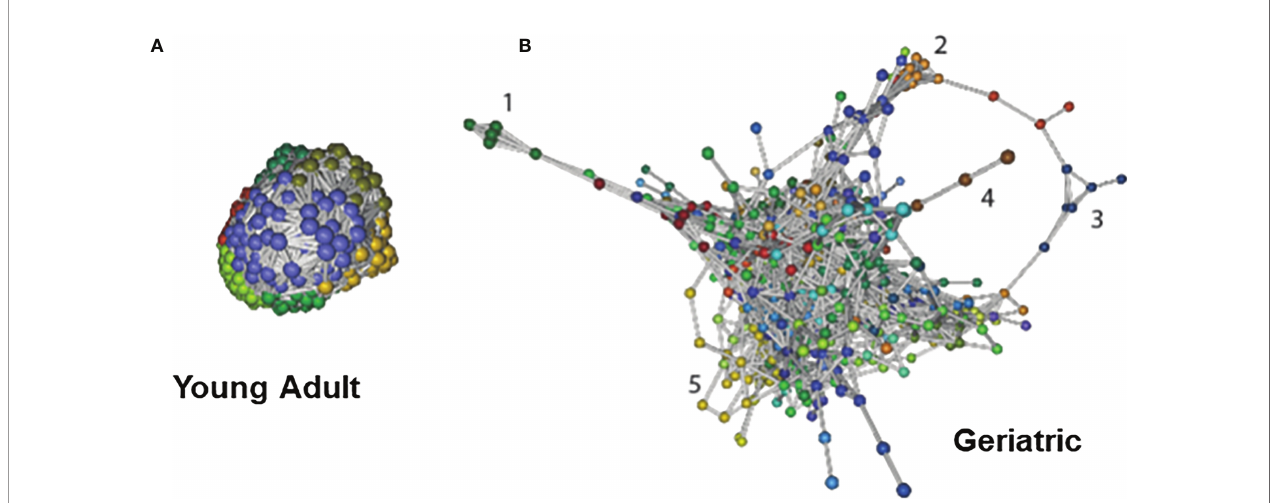
FIGURE 6 | Bacterial association networks and differences with age: Bacterial association networks and differences with age: Markov Clustering Algorithm (MCL) evaluates correlations of vector abundance of bacterial species within each group, thereby generating a cluster map by using correlation scores as distance. Figure shows that microbiome of young adult animals group into a single large super-cluster at microbial homeostasis (A) . However, with age, major constraints have been introduced into the network structure with the emergence of satellite clusters and scattering of the super cluster (B) . Cluster identities are listed in Supplementary Figure 4 . Different colors signify different MCL minor clusters within the microbiome. The data used is species-level identi fi ed list, and the rendering for MCL includes only those with Pearson ’ s r > 0.85 and unidenti fi able feature-level sequences were not included for this